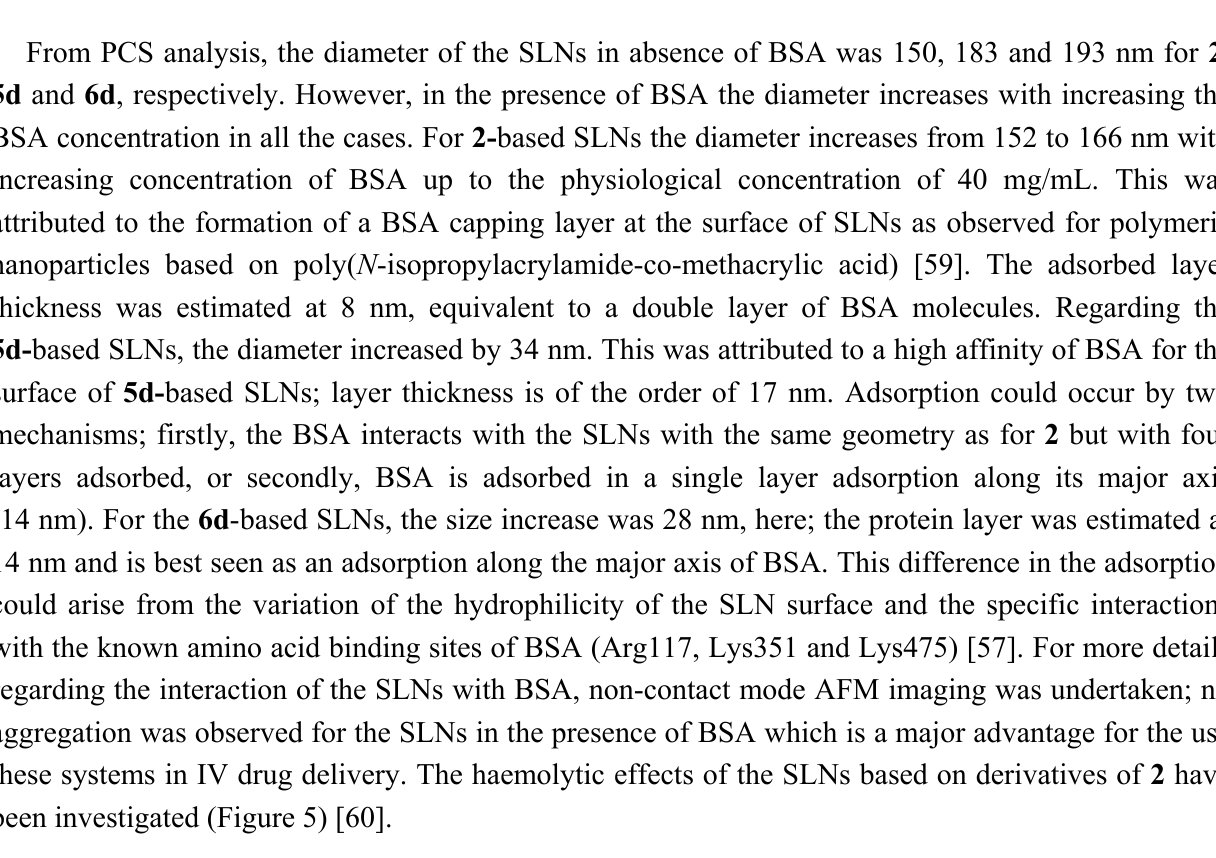
Figure 5. General formulae of the amphiphilic calix-arenes used in the haemolysis